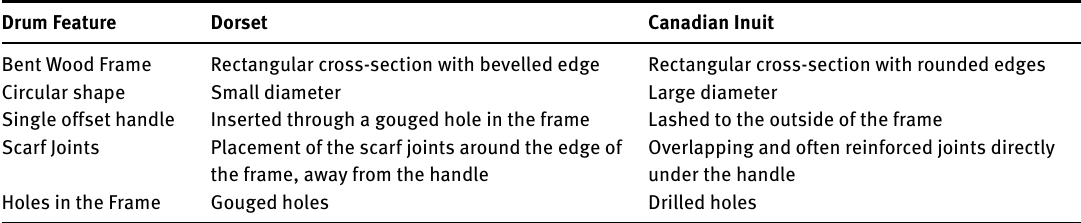
Table 1: Characteristics of Dorset and Inuit Drum